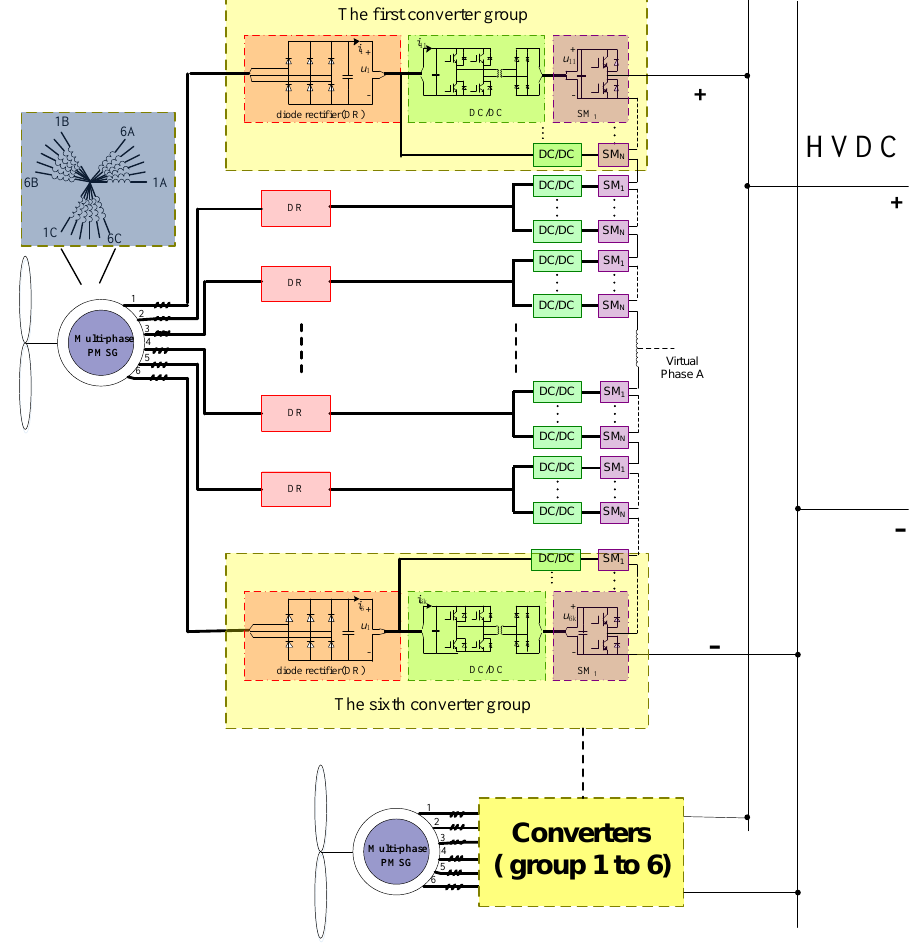
Figure 2. The topology of the proposed wind power generation system with multi-phase permanent magnetic synchronous generator (PMSG) based on high voltage DC (HVDC).